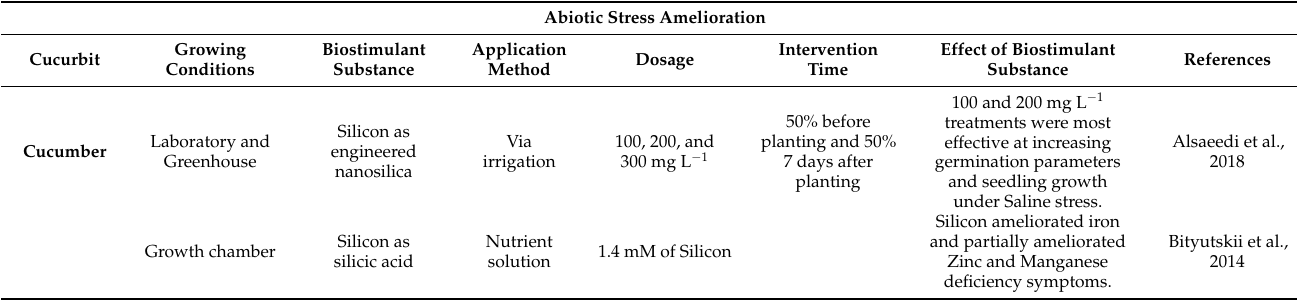
Table 1. An overview of the abiotic stress amelioration, growth improvement, and fruit quality enhancement by biostimulant substances on